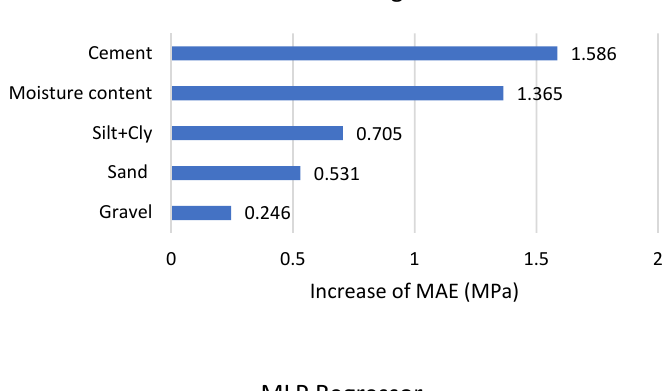
Figure 8. Features’ importance ranking from MSE reduction applied for DTR. The results achieved based on drop-out loss and MSE reduction are collected in the following Table 4. Table 4. Summary of the five rankings (the most important component is at the top of each of the lists). Drop-Out Loss for DTR